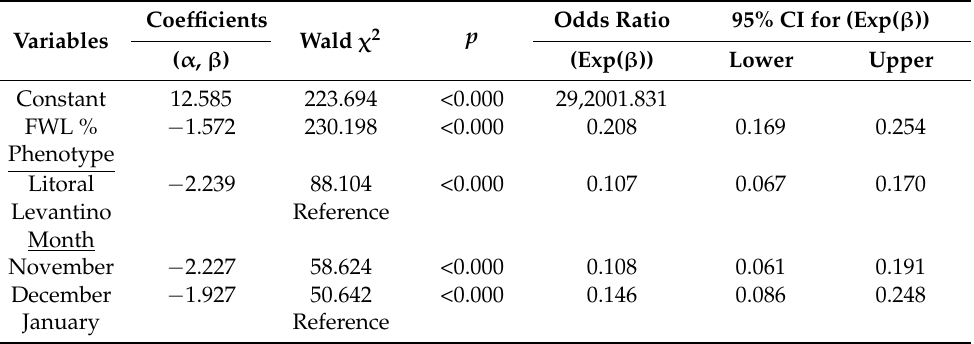
Table 11. Estimation of the multiple logistic regression parameters for the Levantino and Litoral cucumber cultivars.